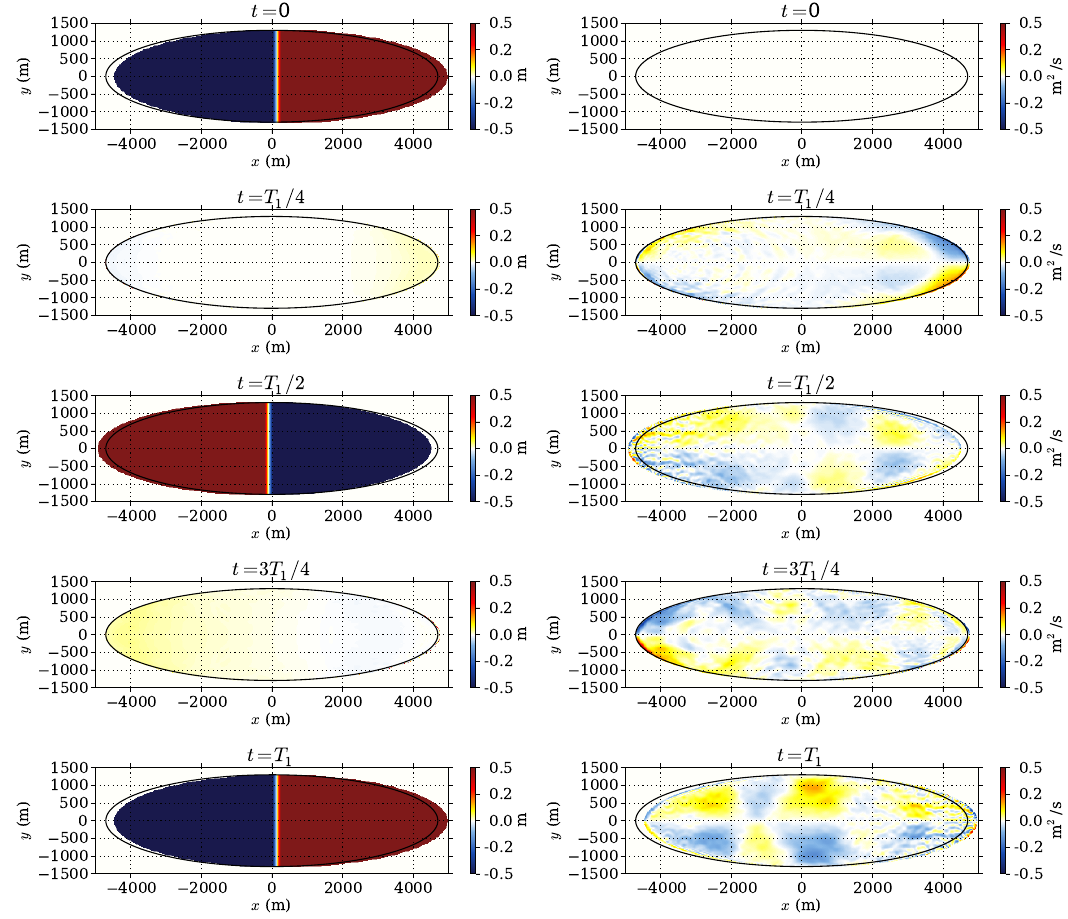
Fig. 12. Benchmark 2: 2-D snapshots of water elevation (left column) and N flux computed by means of the code UBO-TSUFD. Differently from the theoretical problem, the velocity along the y-axis is not null and this leads to an error between numerical and analytical results which increases with